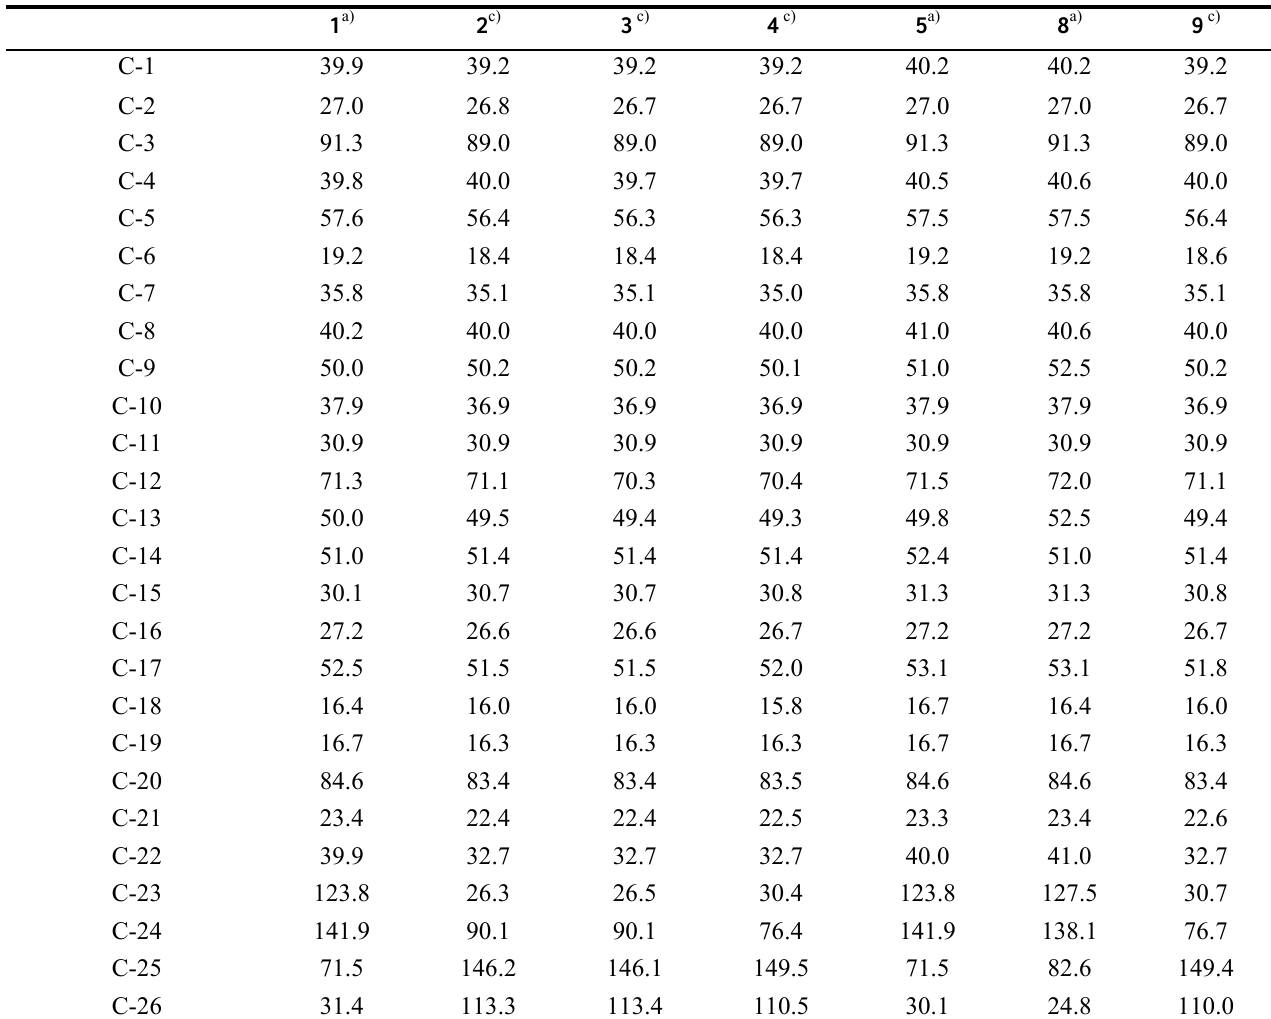
Table 1. 13 C-NMR data for compounds 1-9